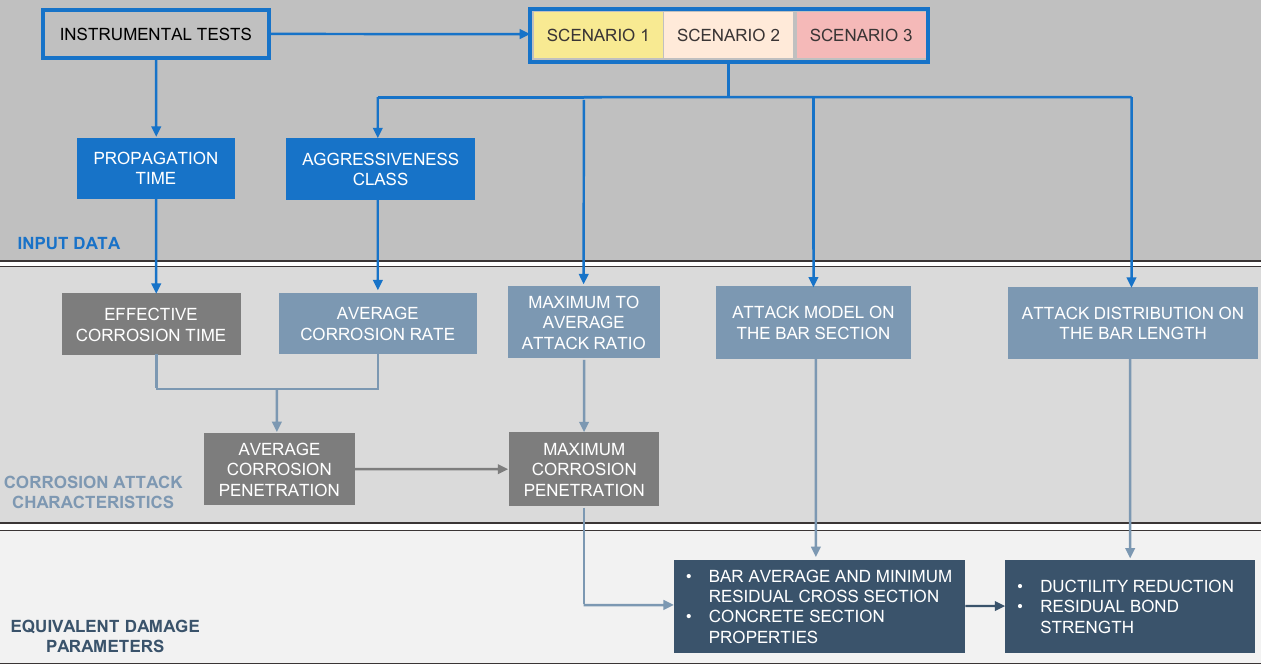
Figure 4. Three-phase process for the definition of the equivalent damage parameters to be imple- mented in the structural analyses: in blue are the input data; in light blue are the corrosion attack characteristics, selected from the scenarios; in dark blue are the final equivalent damage parameters, and in grey is the information calculated.